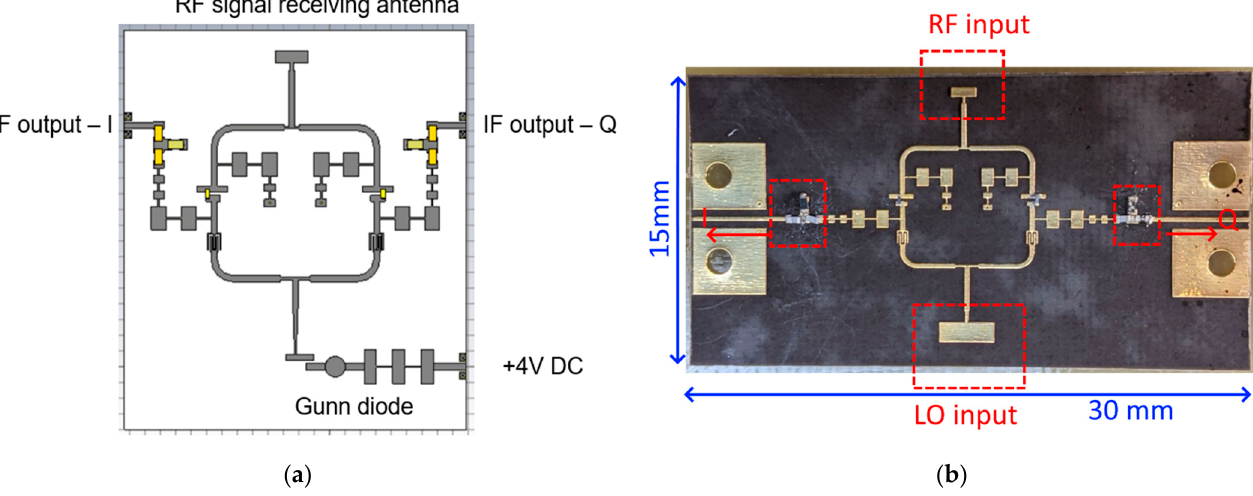
Figure 9. Schematics ( a ) and fabricated PCB board ( b ), containing IQ subharmonic mixer for 110 GHz with antennas for 55 GHz LO oscillator and ~110 GHz input signal with output patch antennas.